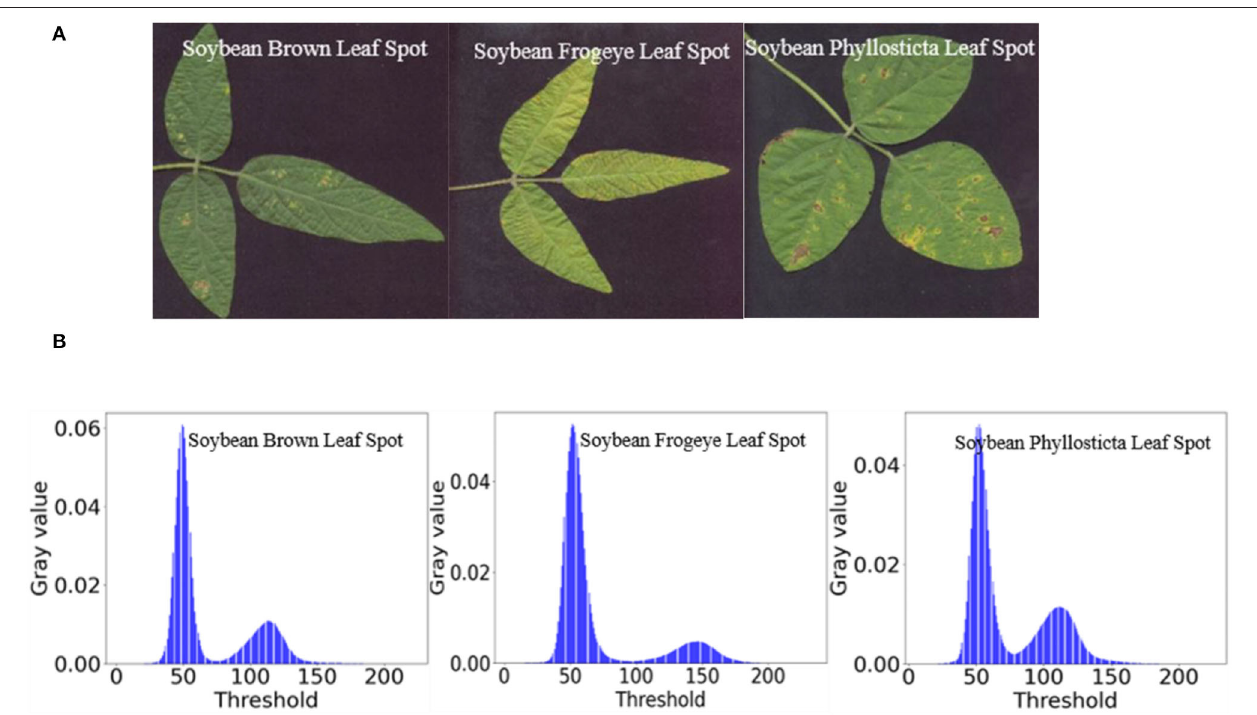
FIGURE 4 | Histogram analysis of soybean disease images. (A) Original images. (B) Gray